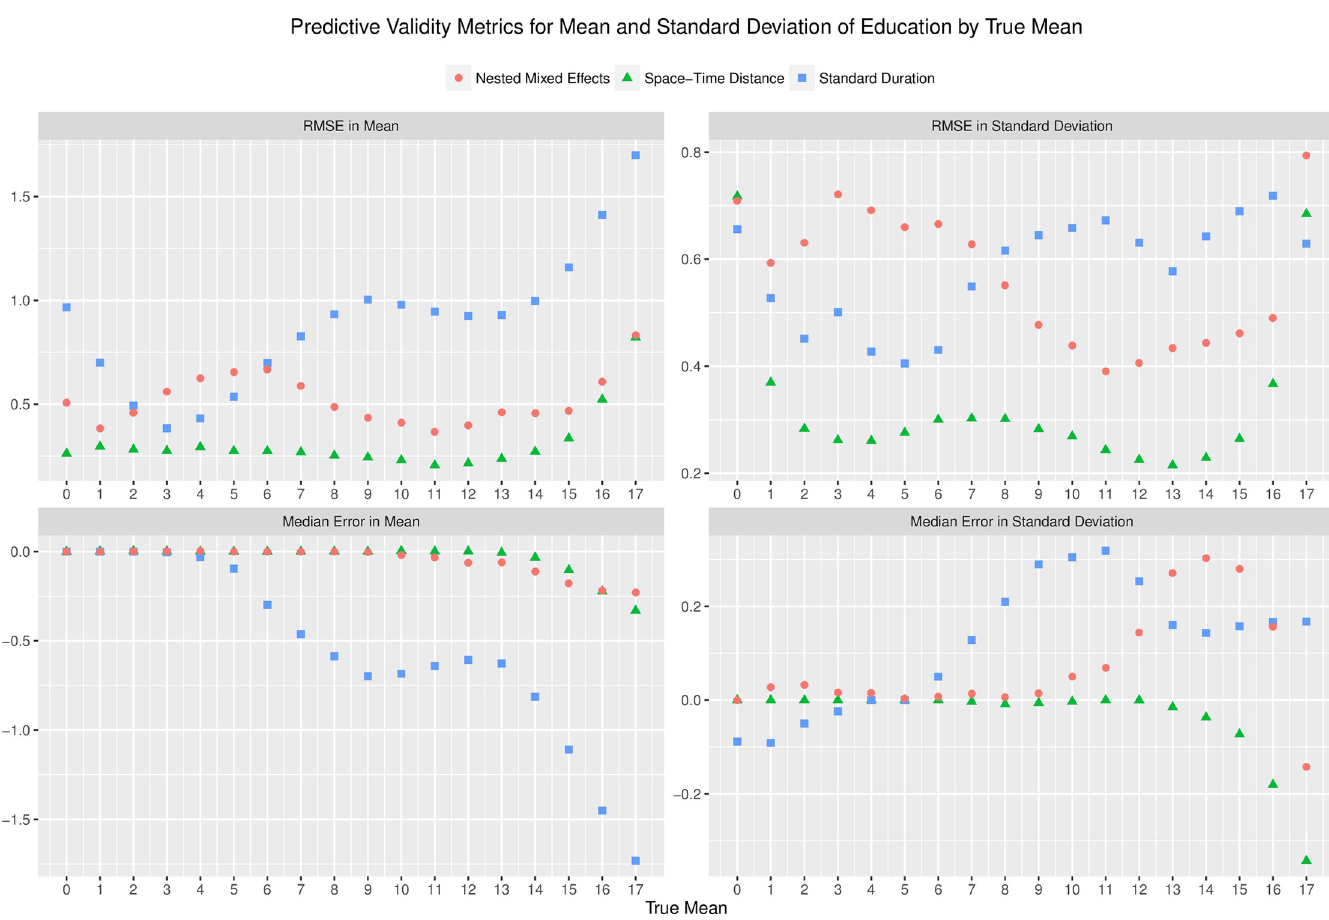
Fig 2. Predictive validity by true mean. Predictive validity metrics for the mean and standard deviation of attainment by one-year increments of true mean attainment in the population. The number shown indicates the lower bound of the interval, e.g. 15 indicates [15,16). Space-time distance model results shown using hyper- parameter set with optimal RMSE in mean attainment. Overall the order of model performance is similar to that shown in Fig 1, across the range of true mean values. The standard duration method increasingly underestimates educational attainment in highly educated populations.